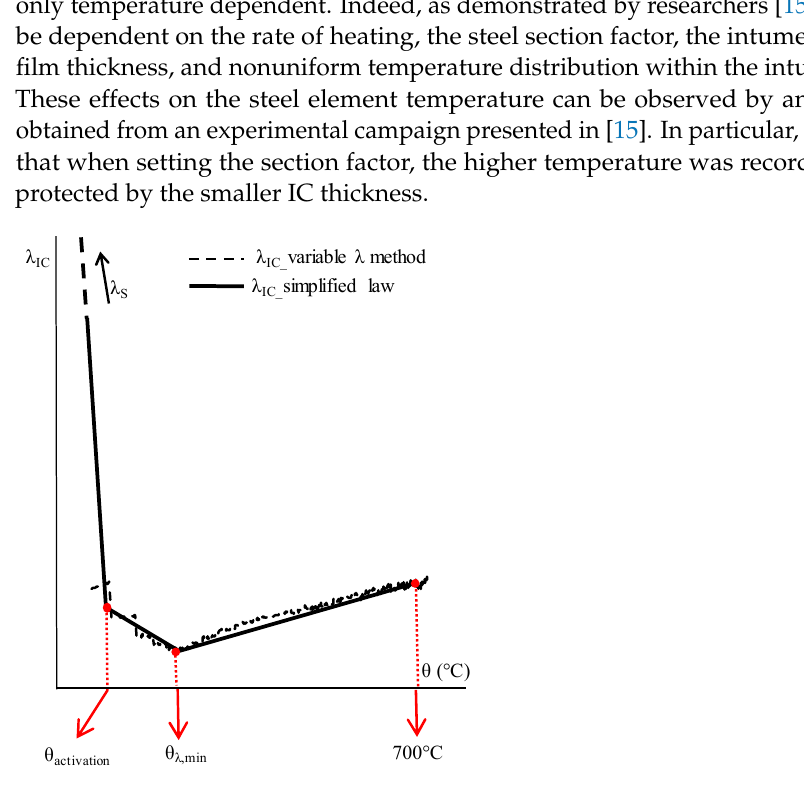
Figure 8. IC thermal conductivity calculated with accurate (EN 13381-8) and simplified laws.